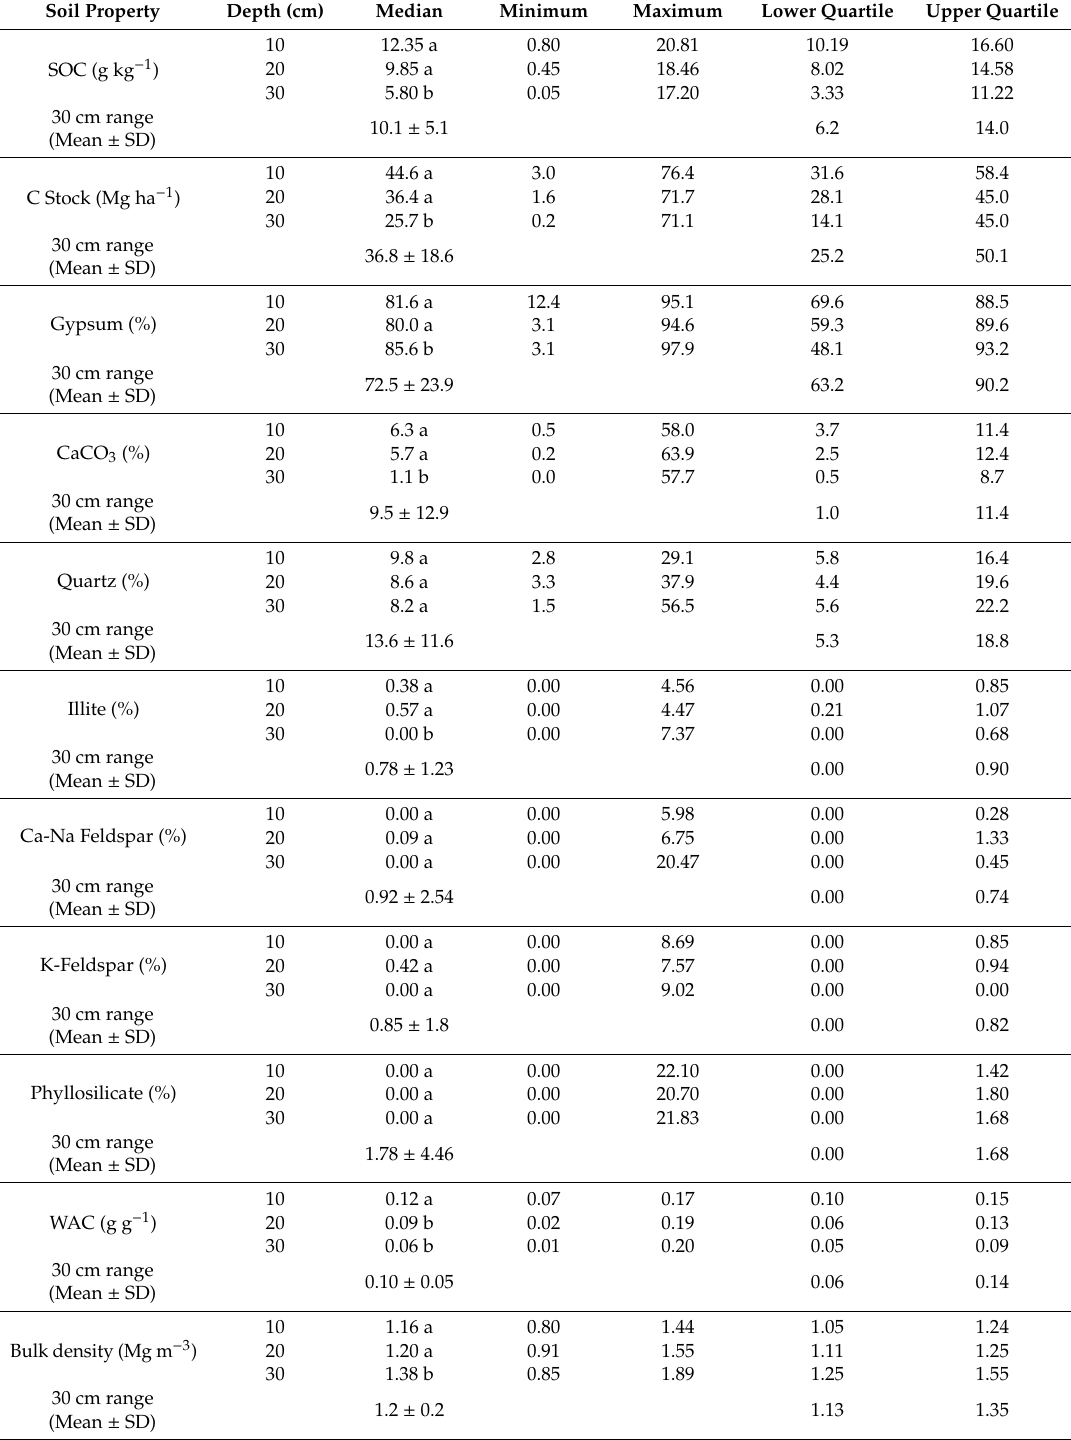
Table 1. Descriptive statistics of physical chemical soil variables. N = 30 samples per depth. Global set of samples = 90 (30 samples × three depths). The available water capacity (AWC) indicates water content in field capacity minus water content in permanent wilting point. Di ff erent letters indicate significant di ff erences ( p < 0.05) between depths. Kruskal–Wallis